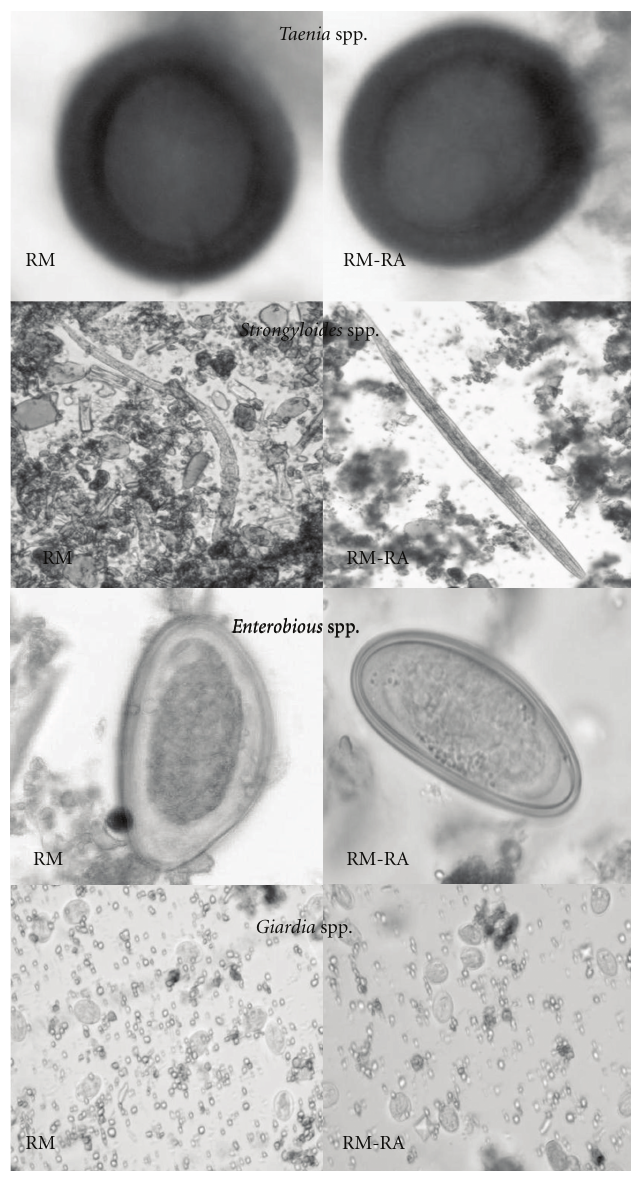
Figure 1: Qualitative Comparison of some eggs, cysts, and larvae found by Ritchie’s methods (RMs) and Ritchie’s methods modified by R´egis An´ecimo